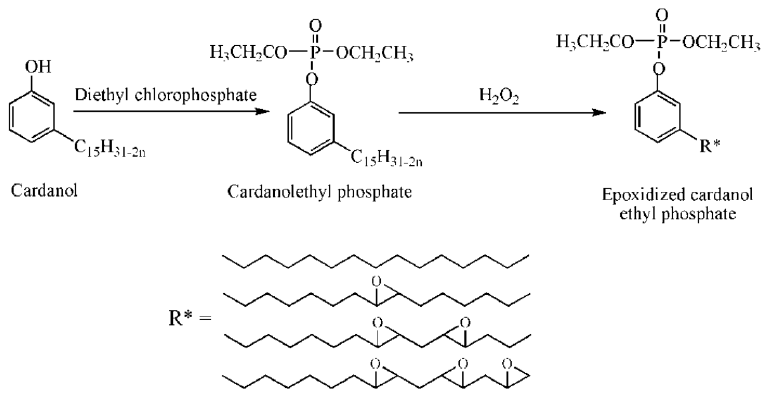
Figure 11. Synthesis of epoxidized cardanol ethyl phosphate.